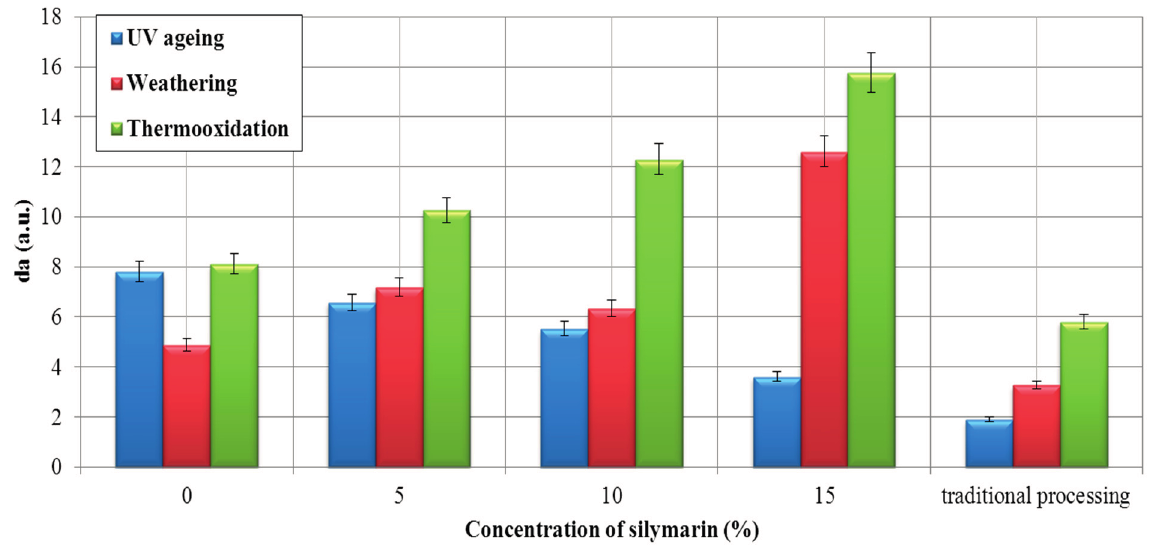
Figure 7. Effect of silymarin on the color of the EPM material. The a index (the red/green coordinate, with + a * indicating red and − a * indicating green) tested in the CIE-Lab coordinate